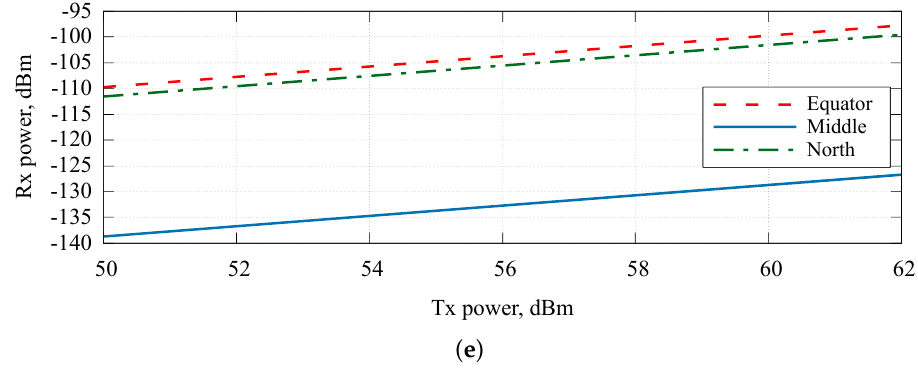
Figure 7. The received power in the sunny weather conditions. ( a ) Rx power as a function of frequency; ( b ) Rx power as a function of altitude; ( c ) Rx power as a function of Tx gain; ( d ) Rx power as a function of Rx gain; ( e ) Rx power as a function of Tx